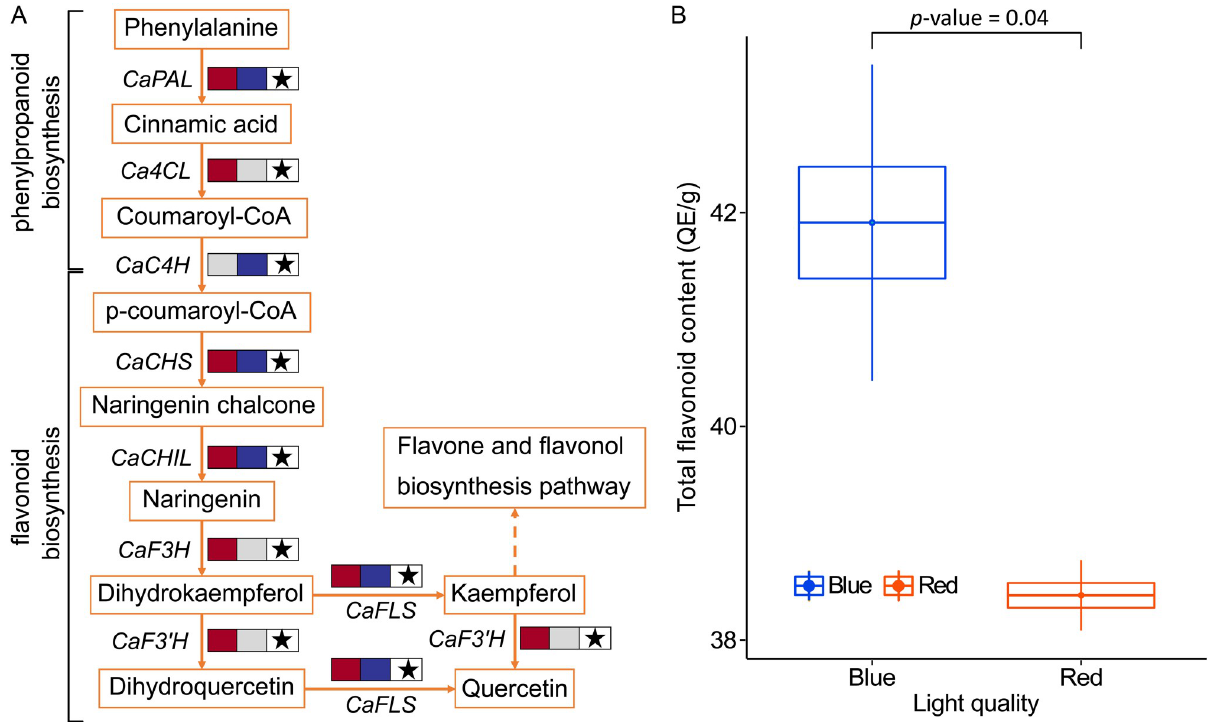
Fig 4. The DEGs involved in flavonoid biosynthesis. (A) The sub-pathway involved in the flavonoid biosynthesis is obtained from the phenylpropanoid biosynthesis pathway and the flavonoid biosynthesis pathway of the KEGG database. Dashed box covers flavonoid biosynthesis pathway. The enzyme encoded by each DEG implicated in each step is shown. The first of the colored boxes shows the expression change of the DEG from the expression comparison between the R-treated and the W- treated C . asiatica . The second box shows the expression change of the DEG from the expression comparison between the B-treated and the W- treated C . asiatica . Up- and down-regulated DEGs are shown in blue and brown, respectively. Light grey shows that the corresponding DEG is insignificantly changed under a particular condition. Star symbol indicates that the expression level under blue light of the corresponding DEG is higher than that under red light. (B) Total flavonoid contents of C . asiatica leaves under white, blue, and red light are shown. Significant difference of flavonoid contents between light conditions is shown with p -value. CaPAL :